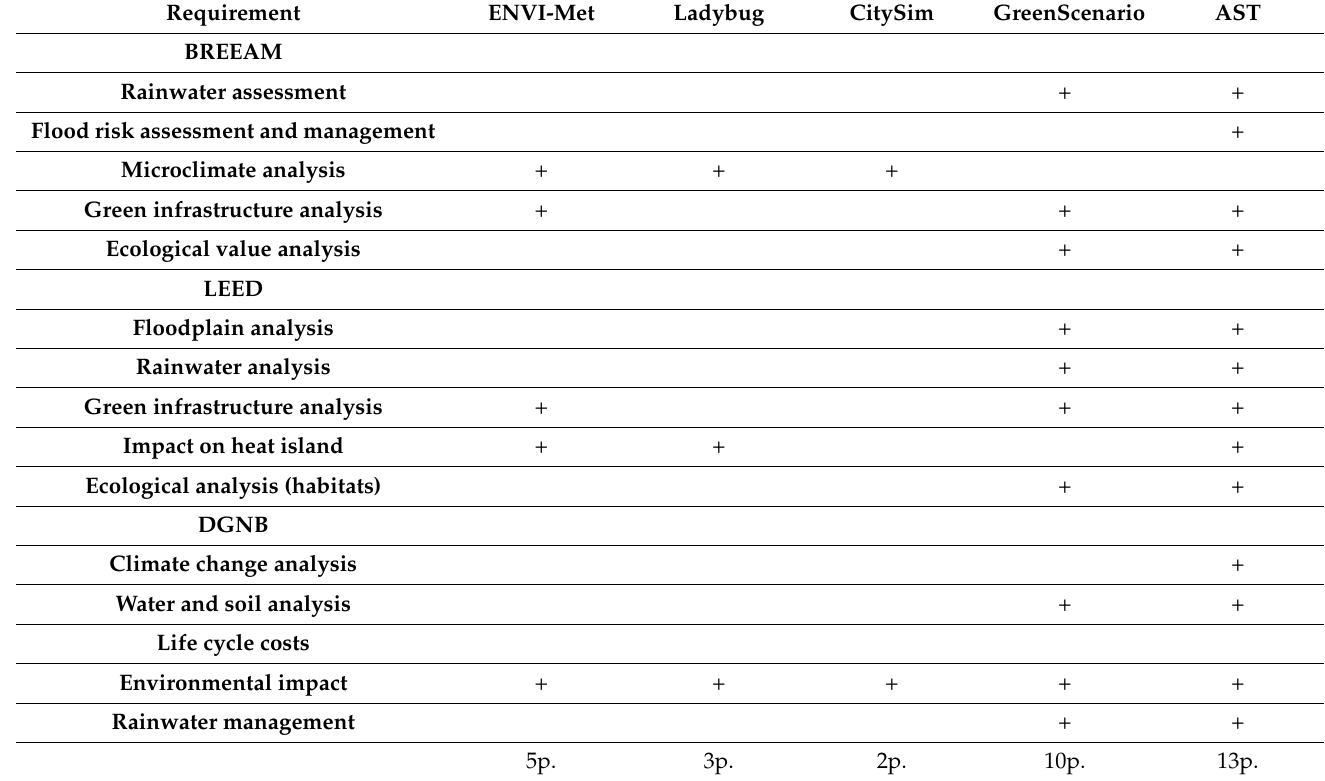
Table 4. The compliance of different software tools with sustainability requirements (source: